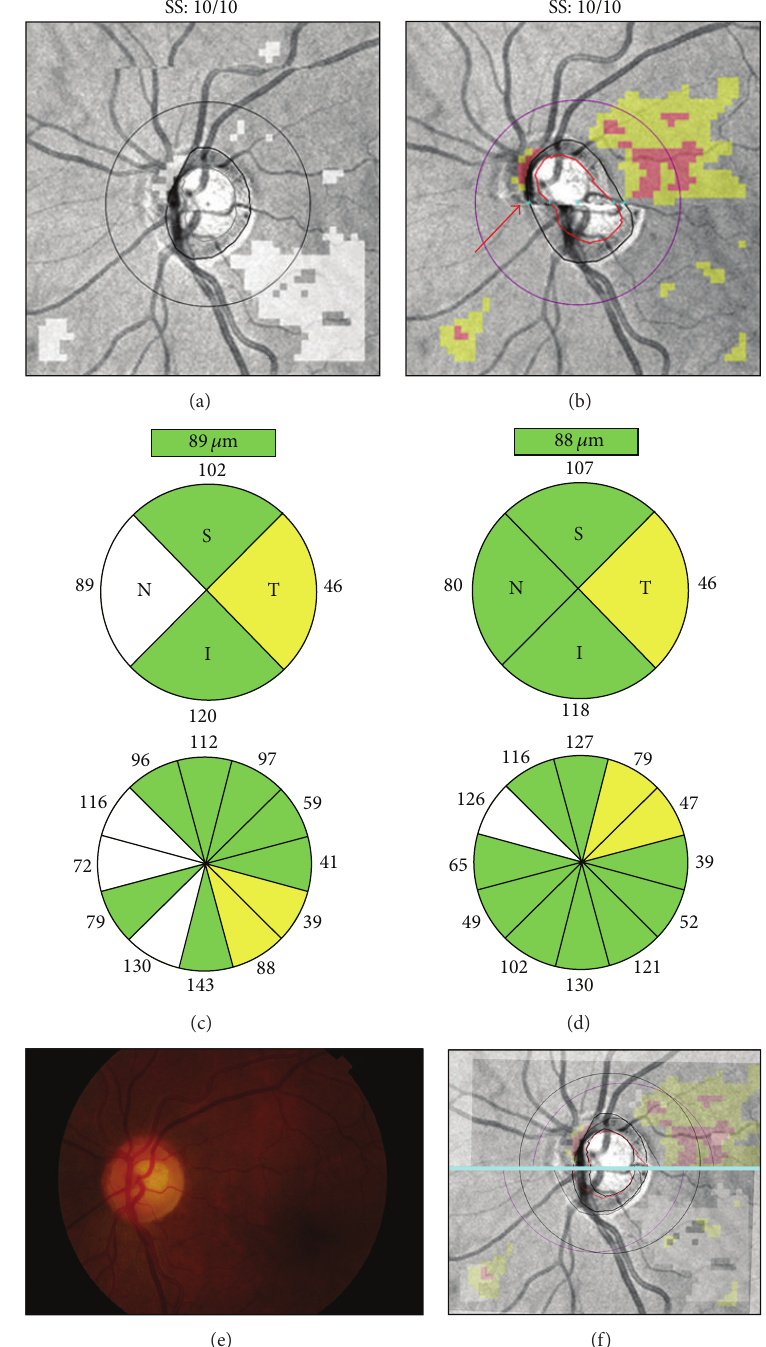
Figure 5: Motion artifacts and scan circle displacement. Pair of Cirrus HD-OCT left optic disc scans collected on the same day ((a)-(b)). In the scan with a motion artifact passing through the optic disc ((b) arrow), printout results suggest superotemporal retinal nerve fiber layer (RNFL) thinning not confirmed by color fundus photography ((d)-(e)). After realignment (f), this scan (purple scan circle) shows temporal displacement above the motion artifact and nasal displacement below the motion artifact. Note RNFL thickening in the sectors moved closer to the optic disc and RNFL thinning in the sectors moved away from the optic disc margin ((c)-(d)). SS: signal